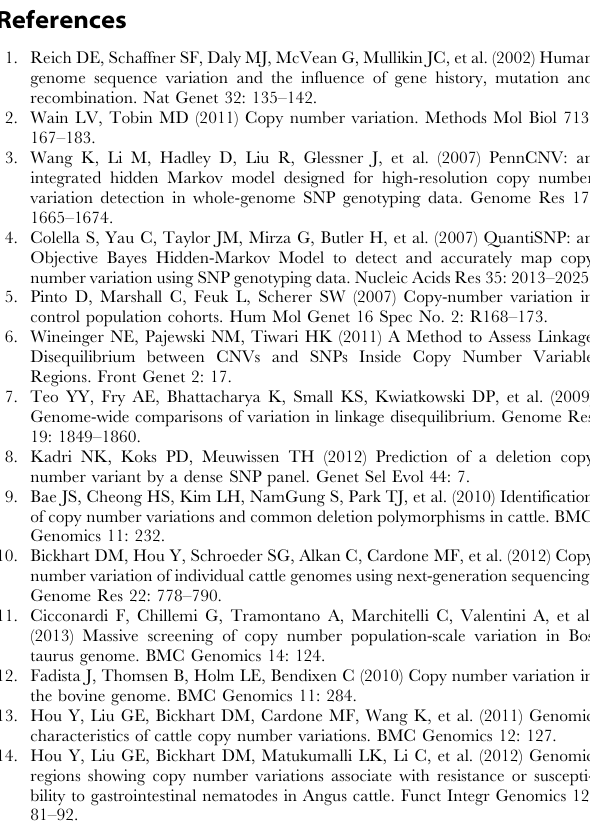
File S3 Table S3. Mean and Median MAF average of 19 breeds. (XLSX) File S4 Table S4. Average values obtained by r 2 for all breeds (LD decay). (XLSX) File S5 Table S5. Variants per Chromosome and average per Megabase. (XLSX) File S6 Table S6A. Type, name and description of genes found in this study. Table S6B : Number of genes per breeds. Table S6C : Number of genes per